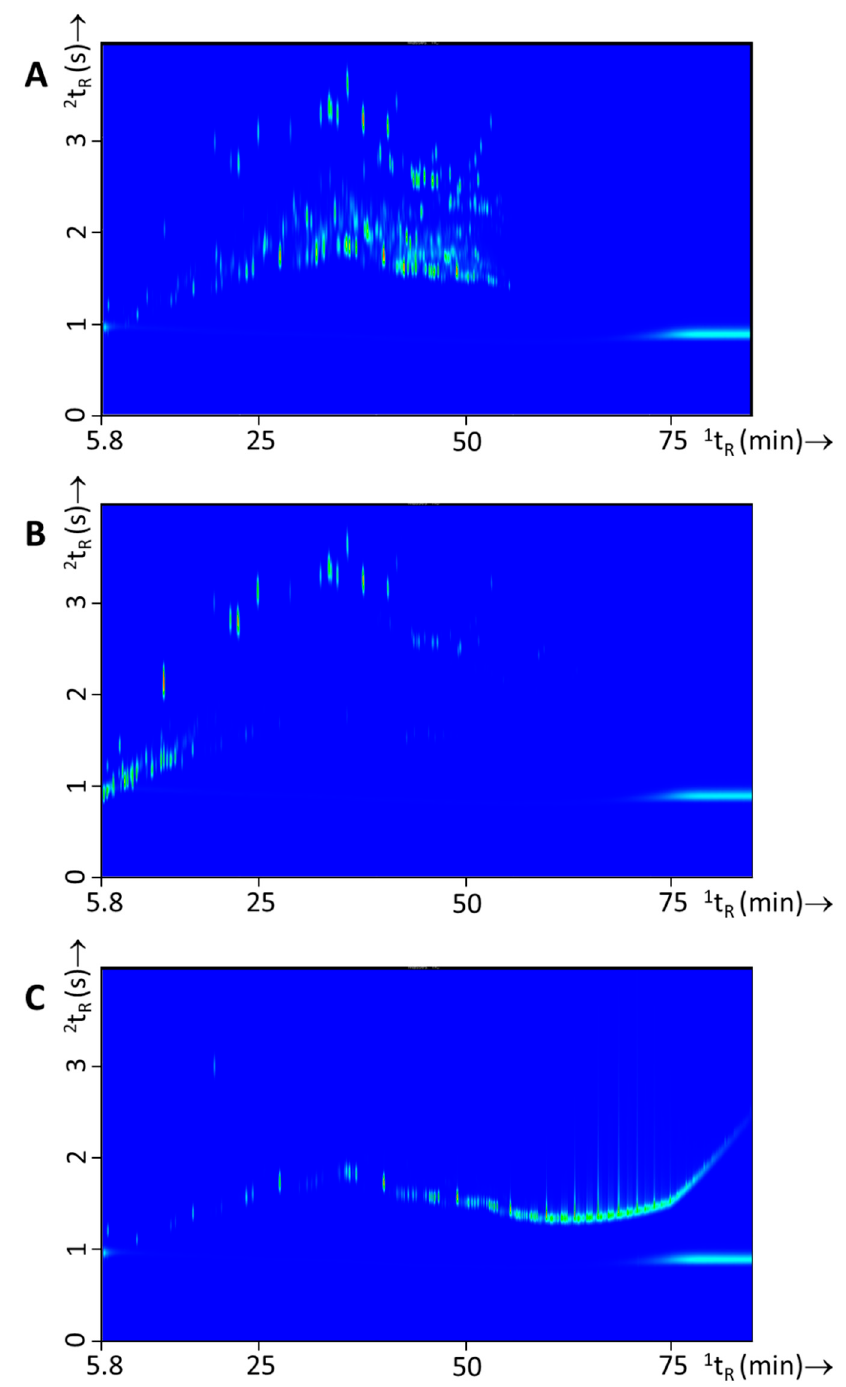
Figure 5. Typical GC×GC-TOFMS TIC contour plots of each of the three classes IL used in this study, i.e., ( A ) white spirit (experiment 110), ( B ) gasoline (experiment 139), and ( C ) lamp oil (experiment 151).